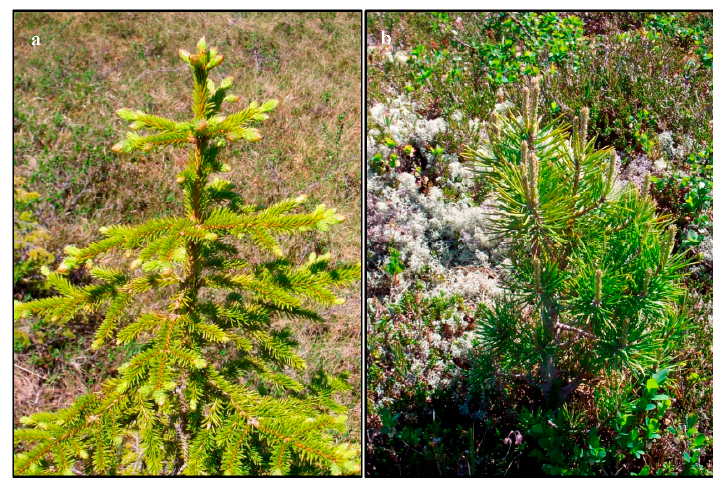
Figure 4. Photographs taken at 11:00 a.m. UTC on 10 June 2007 illustrating the typical status of the trees at the time of the growing season when the three ALS datasets acquired with ALTM Gemini were collected (3:20–3:55 p.m. UTC on 11 June 2007): ( a ) a spruce tree; and ( b ) a pine tree. The photographs show that the buds had just started to burst.